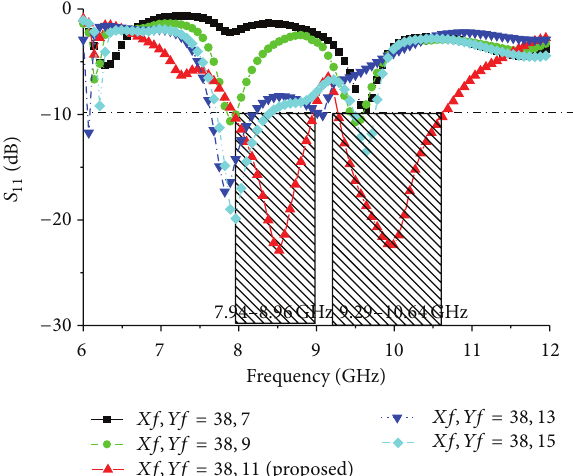
Figure 5: Simulated reflection coefficient of different values for different types of antenna.